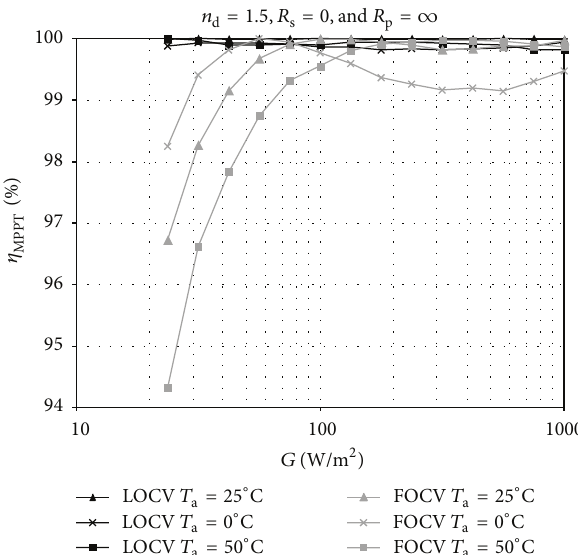
Figure 4: Computed 𝜂 versus 𝐺 by using the FOCV and LOCV MPPT methods for a single PV cell at different values of 𝑇 = 0 , and 𝑅 = ∞ . 1.5 , 𝑅 s p